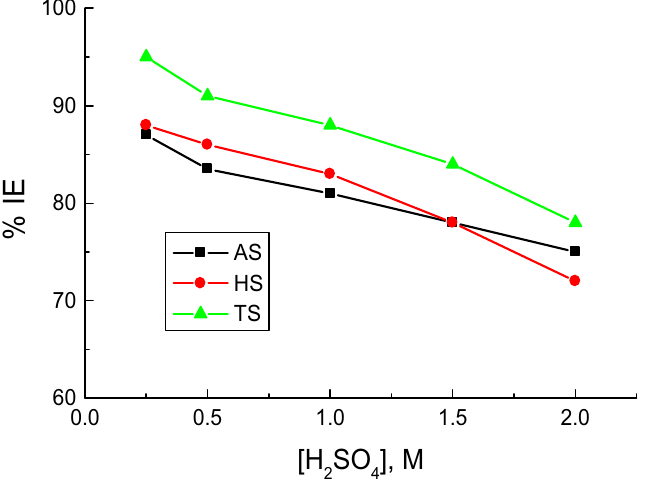
Figure 1. The impact of corrosive medium concentration on the values of % IEs of the examined surfactants in the copper corrosion in H 2 SO 4 solutions at 298 K.